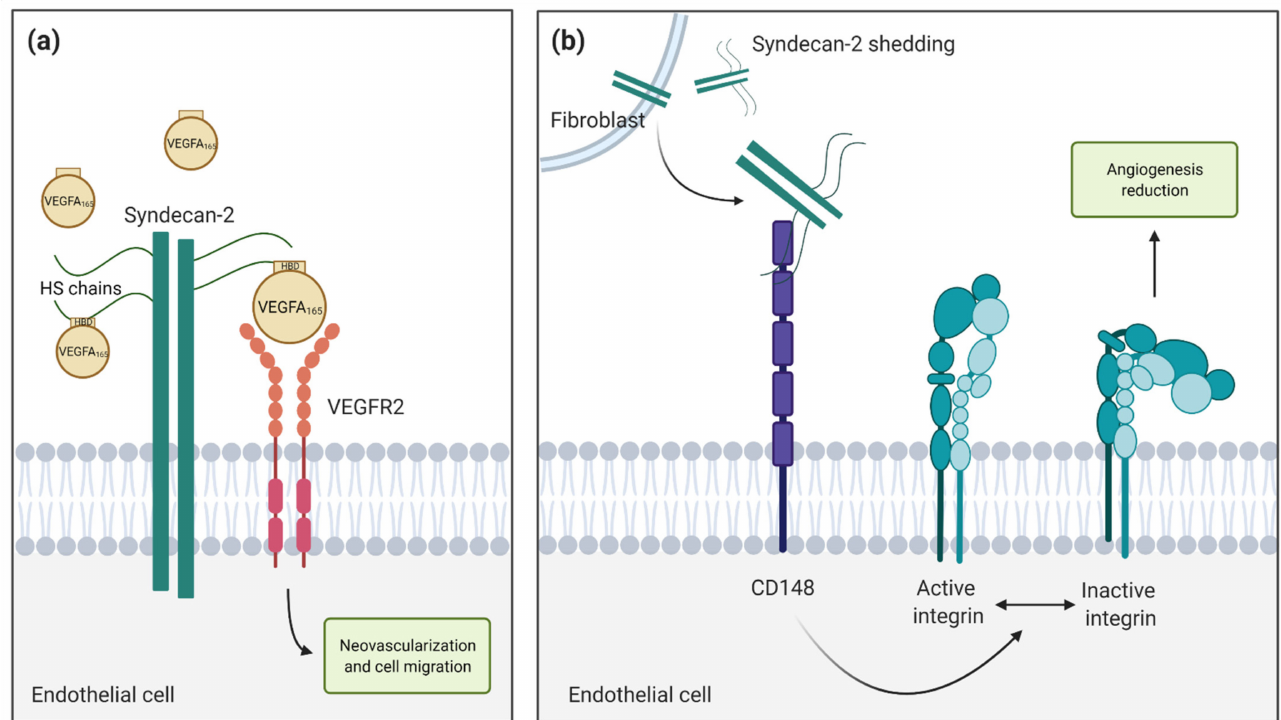
Figure 5. Roles of syndecan-2 in promoting and inhibiting angiogenesis. ( a ) Syndecan-2-VEGFA 165 -VEGFR2 tricomplex promotes angiogenesis. Heparan sulfate chains present in syndecan-2 associate to VEGFA 165 through a heparin binding domain (HBD) increasing its local concentration and enhancing the binding to its receptor VEGFR2 ( b ) Syndecan-2 shedding inhibits angiogenesis. Shed syndecan-2 binds to CD148 which promotes the reduction of β 1-integrin activity in endothelial cells. The inactivation of β 1-integrin reduces cell migration and consequently inhibits